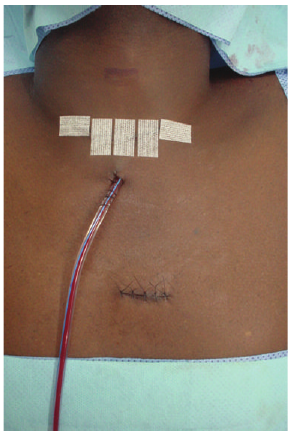
Figure 2: Intramuscular presternal grafted area: final aspect.